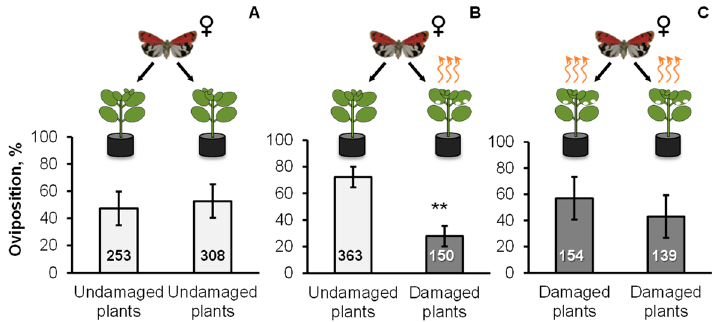
Figure 4. Oviposition preference of U . ornatrix female moths on C . nitens leaves. ( A ) On both sides of one carboard box were placed one undamaged plant. ( B ) On one side of a second box an undamaged plant was used and, on the other side, a plant that had been attacked by six third-instar caterpillars was included. ( C ) A third box contained two damaged plants. Welch’s two sample t -test (** p < 0.01). Values are the mean ± standard error ( n = 7). Each plant pair was used only once. Numbers included in bars correspond to the total number of eggs laid by moths across all replicates.